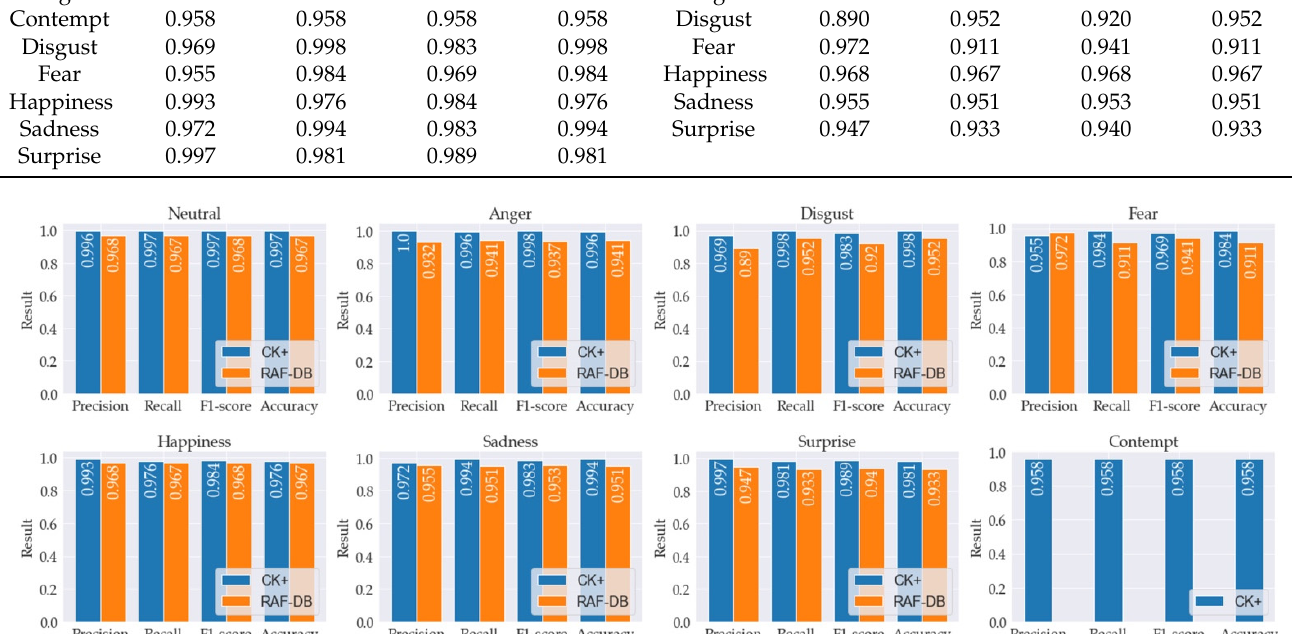
Figure 14. Comparison of the accuracy metrics of the proposed method used on the CK+ and RAF-DB data sets.